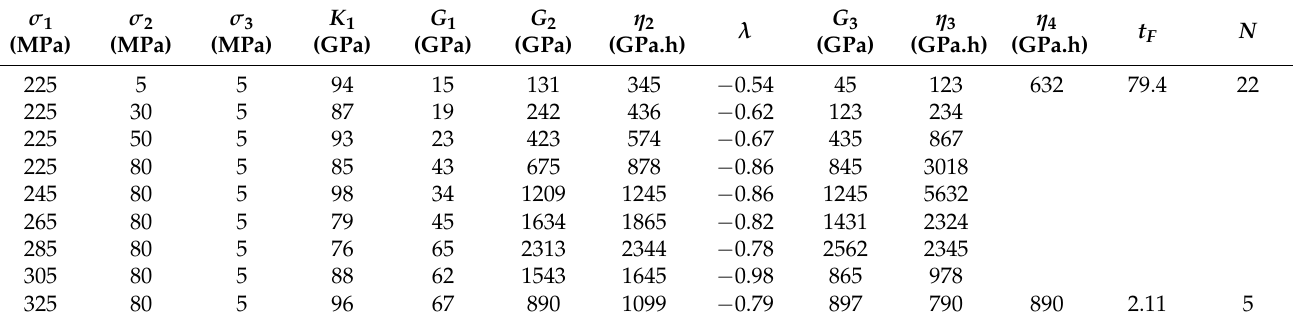
Table 3. Parameters of the marble creep model under true triaxial stress.